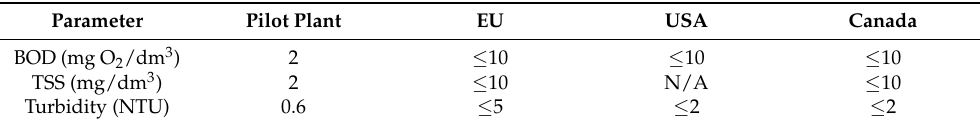
Table 6. Comparison of the quality of water treated in the pilot plant to European [4], Canadian [35], and American [36] quality requirements for water intended for reuse. N/A—not available. Parameter Pilot Plant EU USA BOD (mg O 2 /dm 3 ) Turbidity